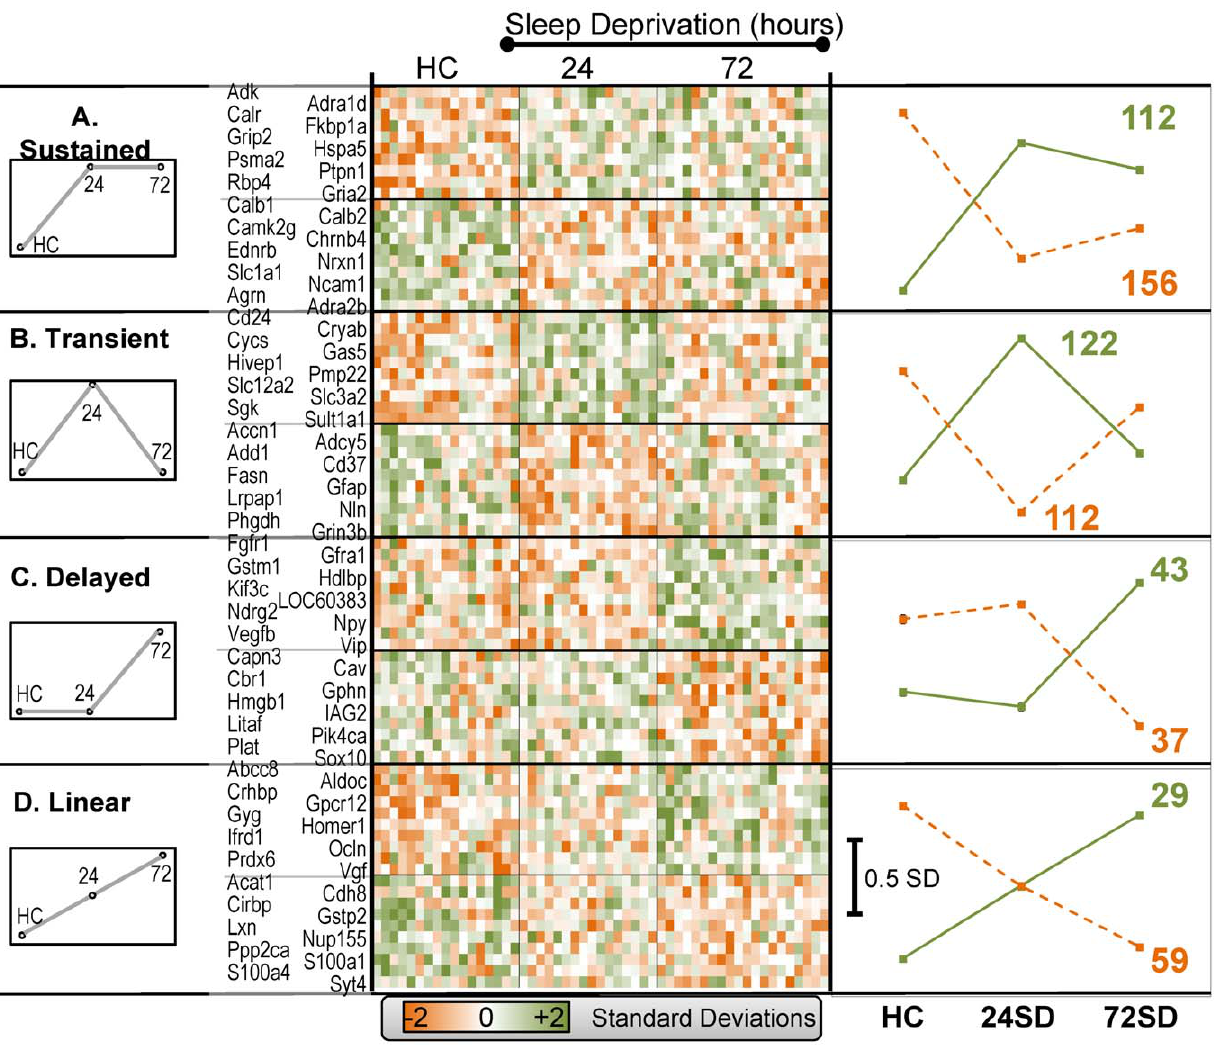
Figure 2. Expression patterns for significant genes are shown. Left: Artificially constructed templates ( A. Sustained; B. Transient; C. Delayed, and D. Linear) were used to partition genes into specified patterns. The treatment group mean expression value for each significant gene was correlated with each of the four templates and the gene was assigned to the template with the highest |R|. Positive correlations are considered ‘increased’ with SD, negative correlations are considered ‘decreased’. Center: Heatmap for 10 representative genes assigned to each template and direction are shown. Data are expressed in standardized units and color coded (lower, color scale) by standard deviations from the mean. Right: Averaged results for all genes in each template are graphed (positive = solid green; negative = dashed orange; # genes in each pattern reported). Note: error bars plotted but obscured by symbols.